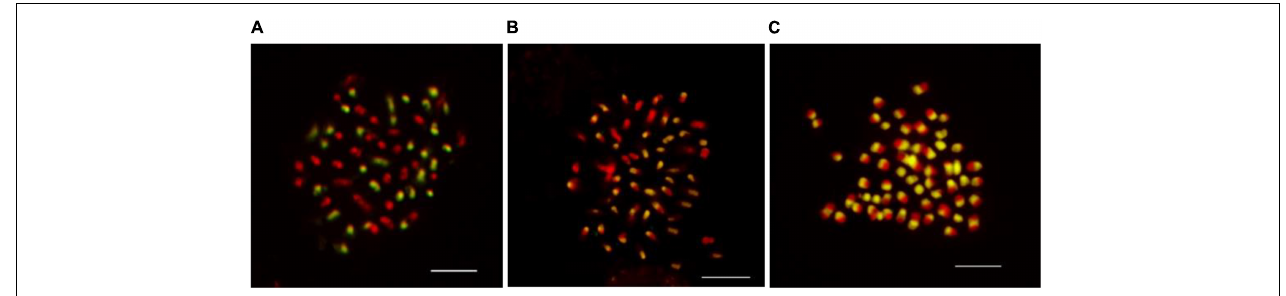
FIGURE 2 | The effect of blocking DNA concentration on genomic in situ hybridization results in kiwifruit. The uses 50 × (A) , 30 × (B) , and 0 × (C) more blocking DNA than the probe were compared in this study. The white scale bar represents 5 µ m.